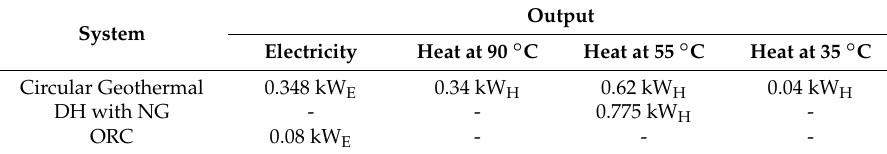
Table 3. Comparison of the Circular Geothermal Option with Conventional